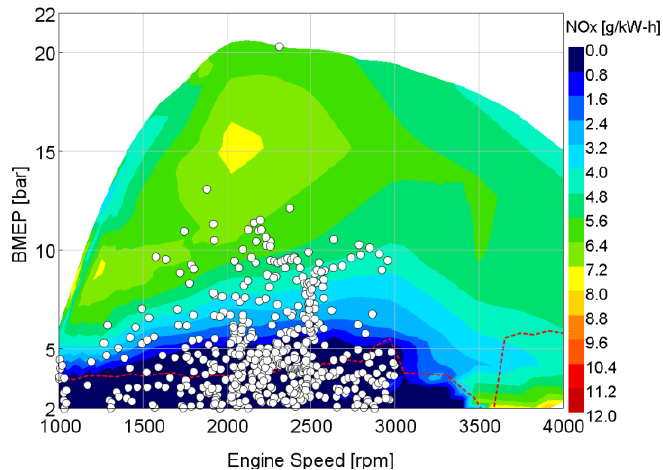
Figure 13. Operating conditions reached during the RDE cycle for CDC ( top ) and dual-mode combustion ( bottom ). Table 6. Rule-based control (RBC) control strategy.